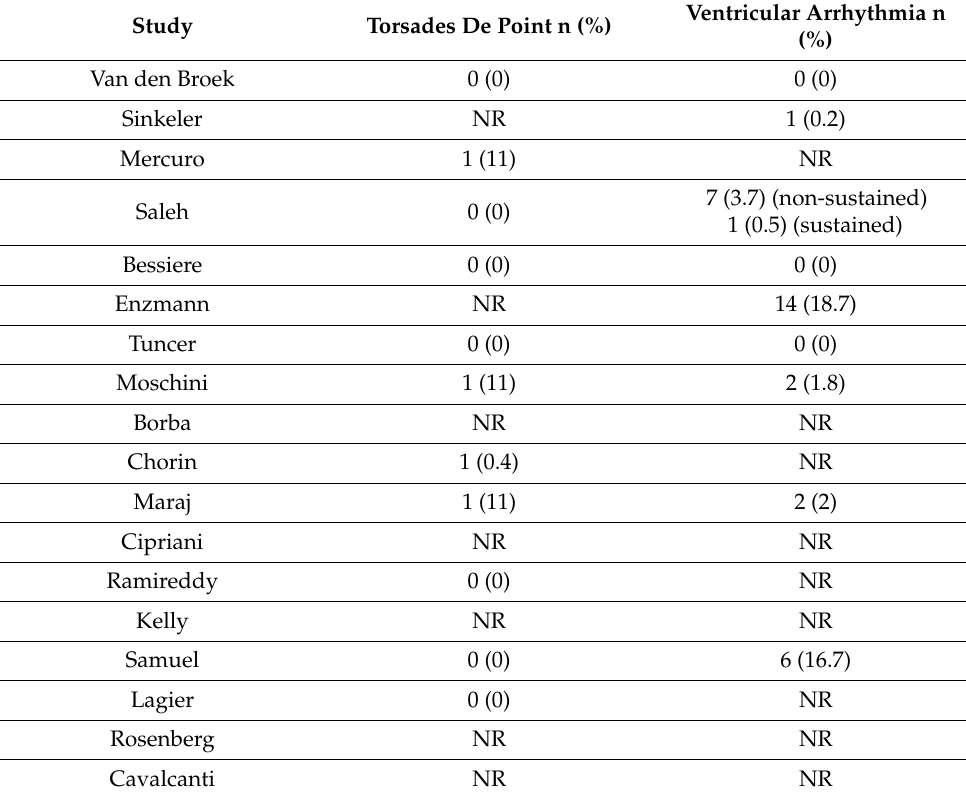
Table 3. Incidence of arrhythmias and torsades de point reported by the included